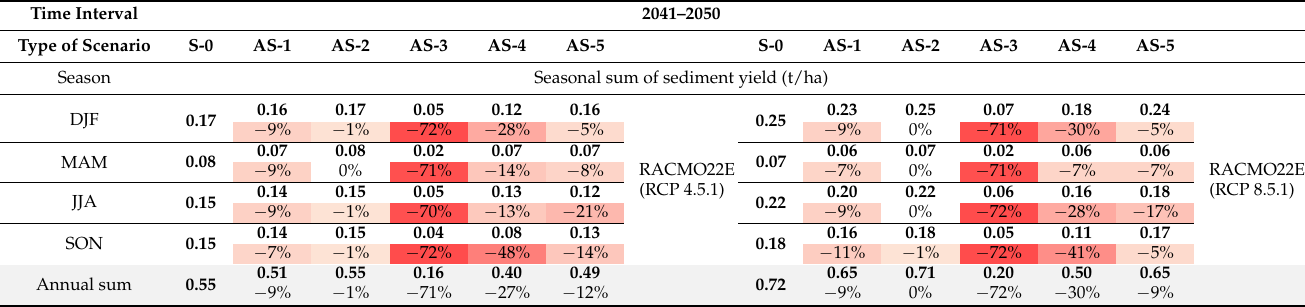
Table 8. Comparison of seasonal sediment yield between scenario 0 (S-0) and adaptation scenarios 1–5 (AS-1, AS-2, AS-3, AS-4, AS-5) for 2041–2050 in the Bystra catchment for climate projections RCP 4.5.1, RCP 4.5.2, RCP 4.5.3, RCP 8.5.1, RCP 8.5.2, RCP 8.5.3. Bold numbers indicate soil water content, and shaded numbers indicate percentage changes (red indicates % decrease in content, and blue indicates % increase in content). Dark red and dark blue shading indicates large changes, while light red and light blue shading indicates small changes (own